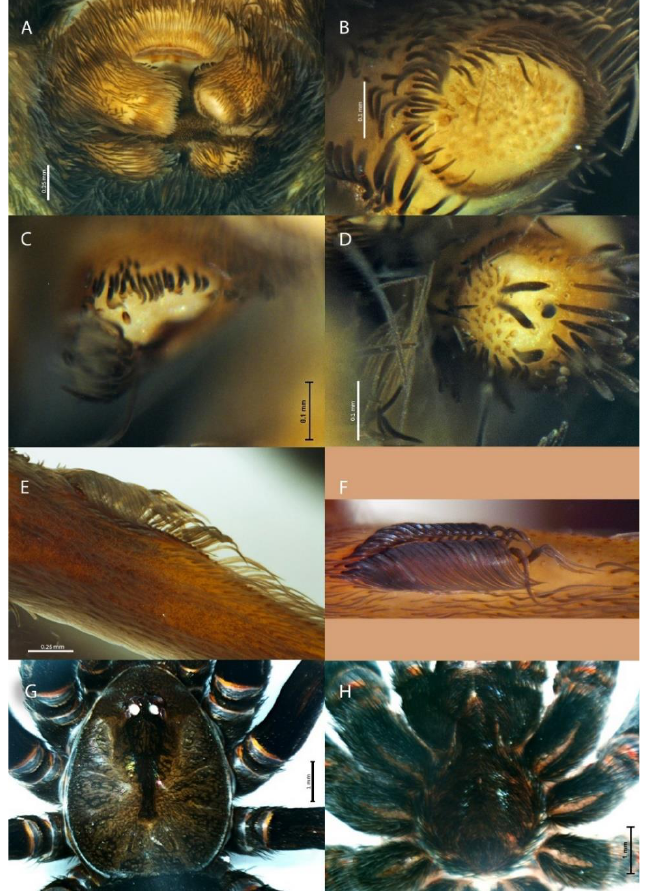
Figure 12. Sahastata aravaensis sp. nov. ( A – E ): Holotype HUJI-AR 20302, G-C: Paratype HUJI-AR 21001. ( A ): Spinnerets, ( B ): left anterior lateral spinneret, ( C ): left posterior median spinneret, ( D ): left posterior lateral spinneret, ( E , F ): calamistrum, ( G ): cephalothorax dorsal, ( H ): sternum. Pictures: ( A – E ), ( G , H ): Zeana Ganem, ( F ): Efrat